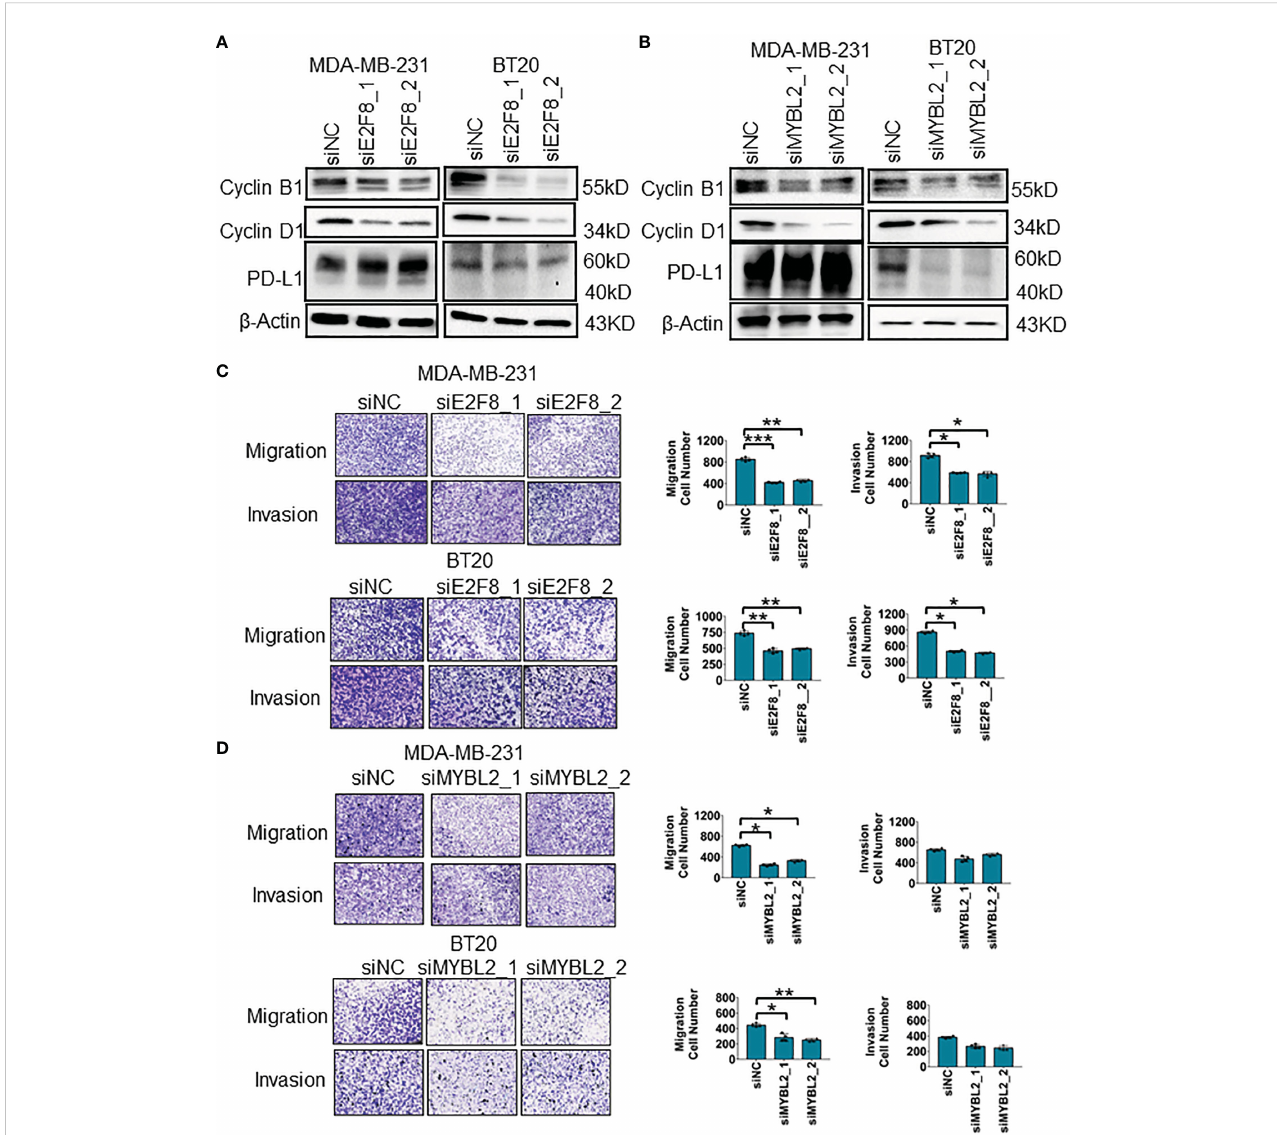
FIGURE 5 The migration and invasion analysis for basal-like breast cancer cells. (A) The expression of cyclin B1, cyclin D1, and PD-L1 in MDA-MB-231 and BT20 cells treated with E2F8 siRNA compared with siNC, as assessed by Western blot assay. (B) The expression of cyclin B1, cyclin D1, and PD-L1 in MDA-MB- 231 and BT20 cells treated with MYBL2 siRNA compared with that of siNC by Western blot assay. (C) Transwell assay analysis for the migration and invasion of MDA-MB-231 and BT20 cells treated with siNC and siE2F8 oligos. (D) Transwell assay analysis for the migration and invasion of MDA-MB-231 and BT20 cells treated with siNC and siMYBL2 oligos. * p < 0.05; ** p < 0.01; *** p < 0.001 compared with the siNC